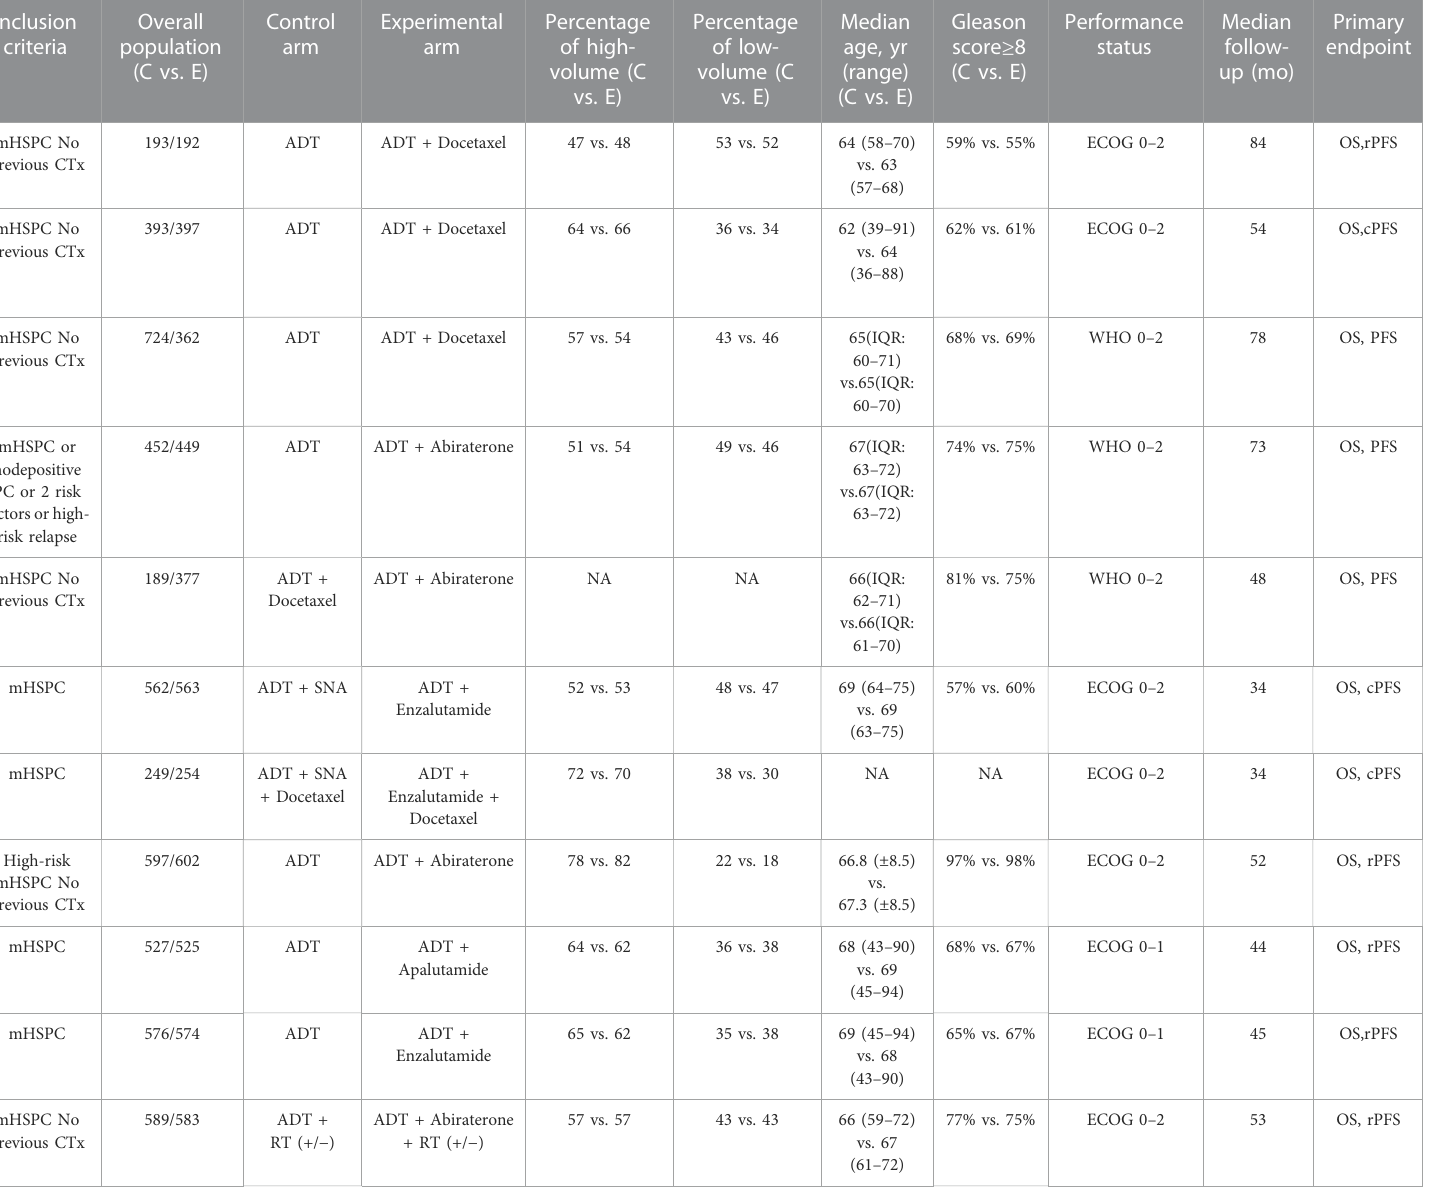
TABLE 1 Characteristics of clinical trials included in the network